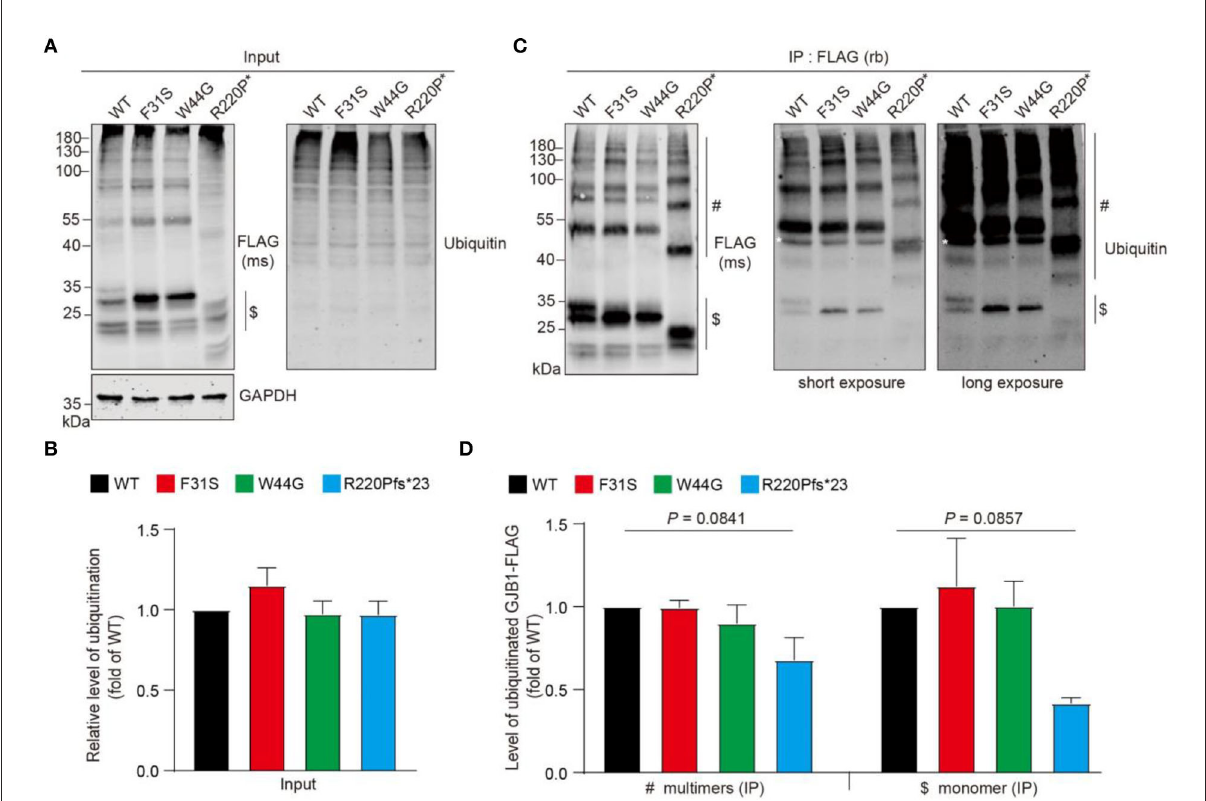
FIGURE6 Ubiquitination assessment of GJB1 species in transfected HeLa cells. (A) GJB1-FLAG variants expressing HeLa cells were lysed as immunoprecipitation input and probed with anti-GJB1 antibody. Ubiquitinated proteins were detected with a pan anti-ubiquitin antibody. $ indicates GJB1 monomers. (B) Quantification of ubiquitination levels in input lysate ( n = 4 per group). No significance was observed. (C) Cell lysates in A were immunoprecipitated (IP) with an anti-FLAG antibody raised in rabbit (rb) and then probed with an anti-FLAG antibody raised in mouse (ms) and an anti-ubiquitin antibody. White * in the blots indicates a heavy chain of the antibody. $ indicates GJB1 monomers and # indicate multimer species. (D) Quantification of ubiquitinated GJB1-FLAG was performed by normalizing band density of ubiquitin signal to GJB1-FLAG signal in corresponding samples ( n = 3 per